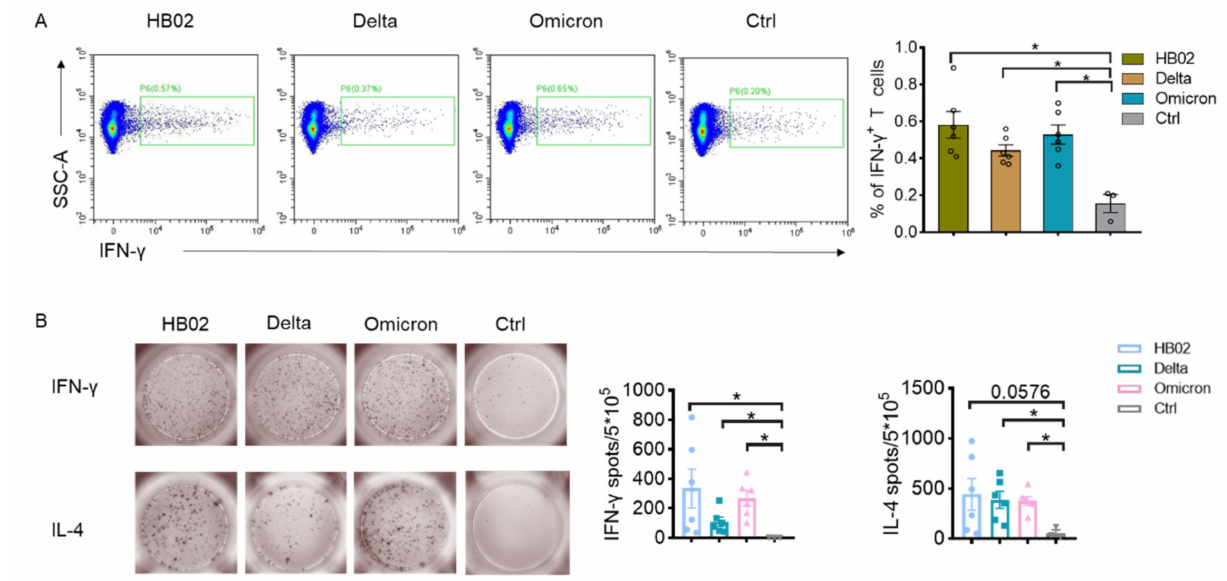
Figure 2. The vaccine-induced immune response. ( A ) Representative flow cytometry figures and per- centages of IFN- γ -expressing T cells (gated in live CD45+ CD90+); ( B ) ELISPOT analysis of IFN- γ and IL-4 in spleens from vaccinated mice. Error bars represent SEM. * p < 0.05 (( A , B ), Mann–Whitney